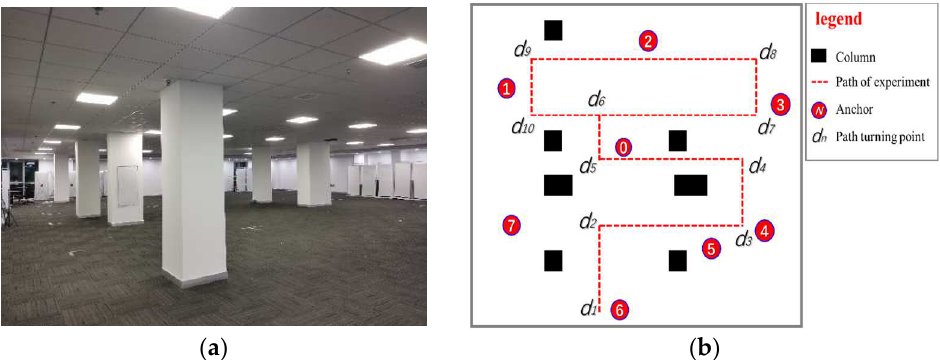
Figure 6. Experimental Site 1 environment and experimental route. ( a ) Site environment and ( b ) site plan and experimental path.